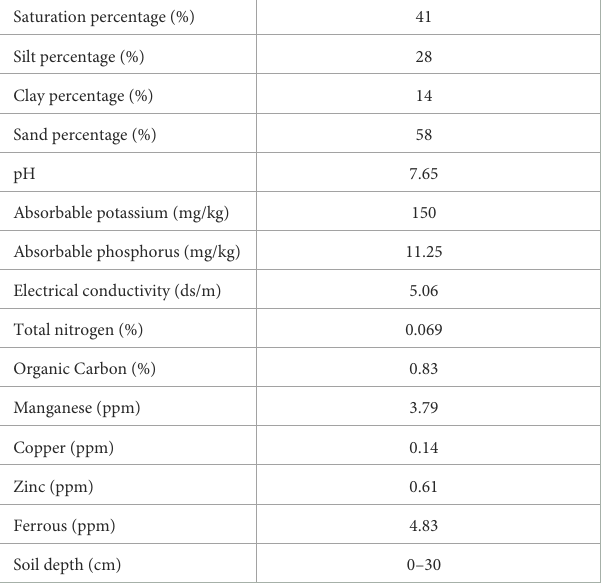
TABLE 2 Characteristics of the chemical and structural parameters of the greenhouse soil sample used for sweet pepper